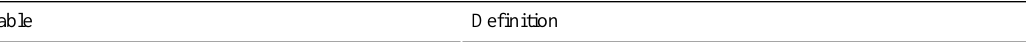
Table 1. Variable